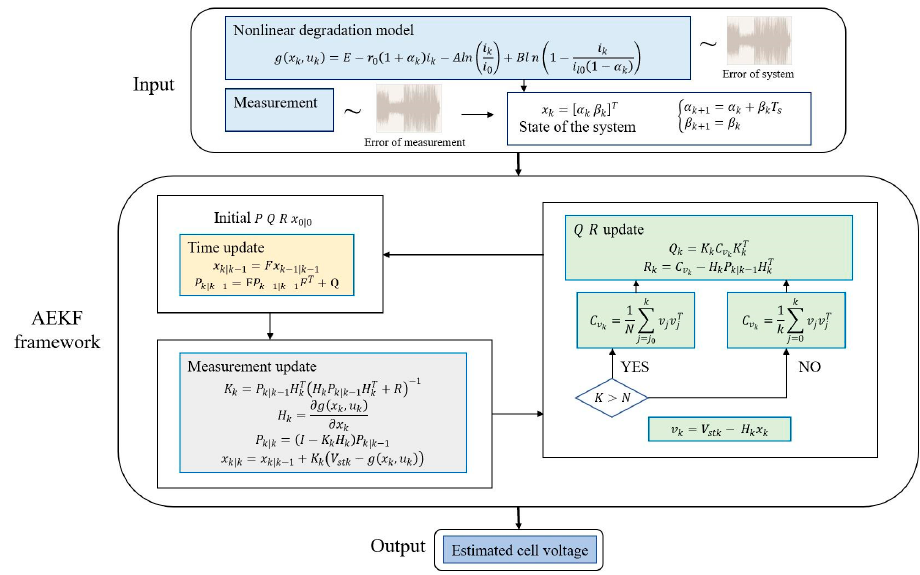
Figure 4. Adaptive extended Kalman filter (AEKF) framework.